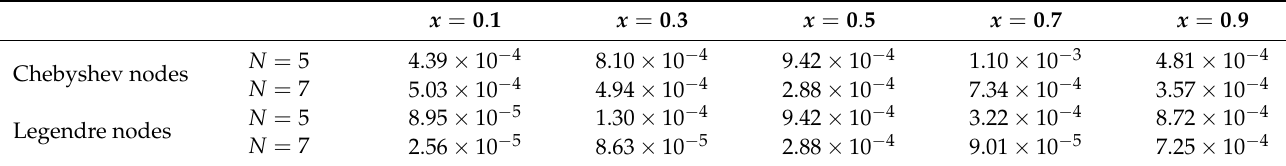
Figure 3. Plot of the exact and approximate solutions taking r = 7 ( left ) and r = 5 ( right ) at Chebyshev nodes for Example 2. Table 3. The L ∞ –error taking µ = 1 for Example 2.